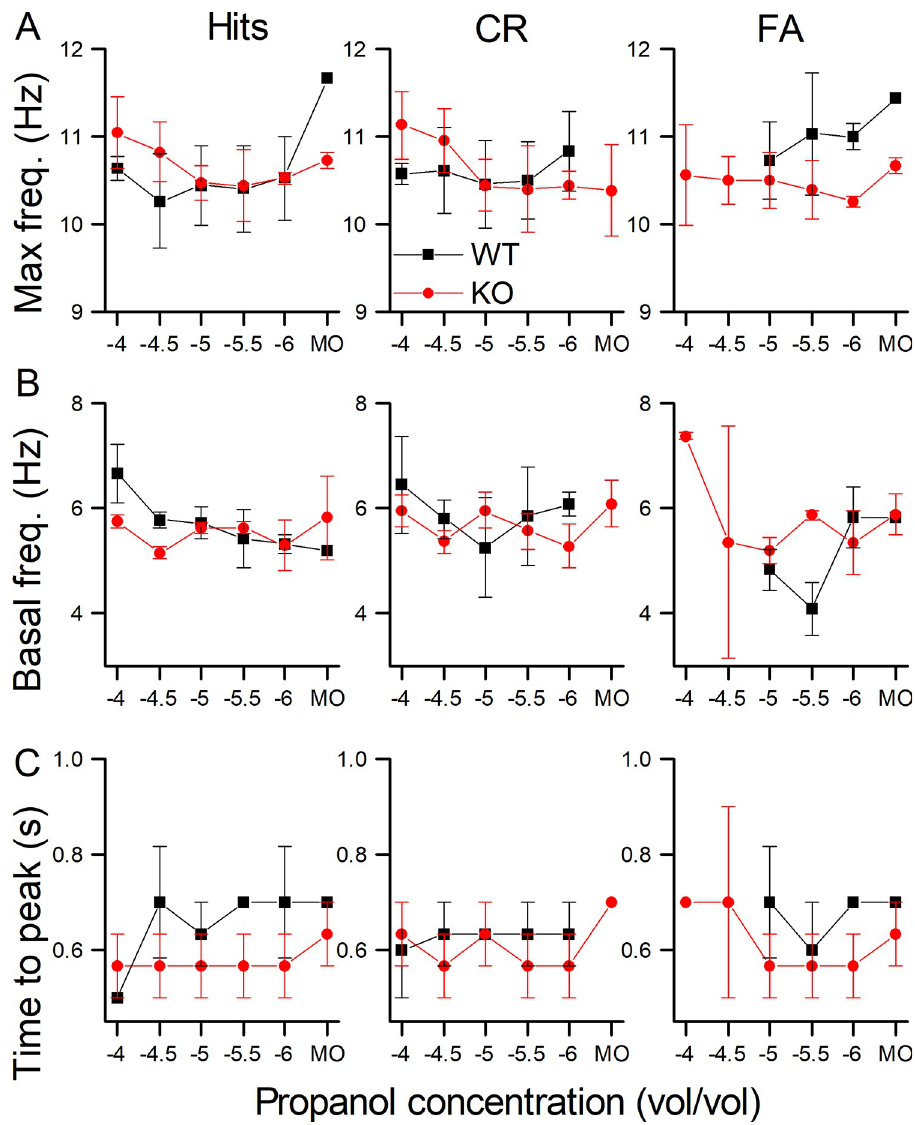
Fig 4. Parameters of sniff responses during odorant sampling. A Peak sniff frequency during odorant sampling for WT and NCKX4 KO mice for Hits, CRs and FAs. B Baseline sniff frequency averaged across all sniffs from -1 to 0 s. C Time to reach maximal sniff frequency calculated from the odorant onset at 0.5 s. Basal frequency and Max frequency had odorant concentration as the only term remaining in the model and it is significant as the main effect (F = 2.64, p = 0.03 and F = 2.8618, p = 0.03 respectively). Data points are averages ± SEM of 3 WT and 3 KO mice. The x-axis displays the log of the odorant